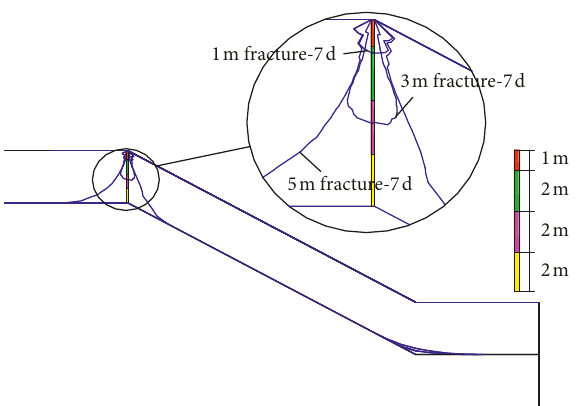
Figure 6: Distribution of the infiltration line around the fracture in different fracture depth (7 days of rain).